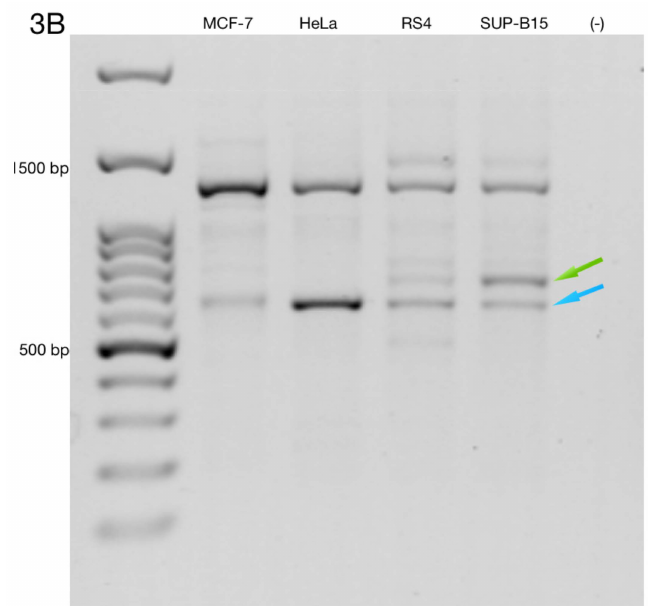
Figure 3. Rapid amplification of 3 (cid:48) cDNA ends for the ZNF695 transcript variants expressed in the cancer cell lines. ( A ) Expression of the RPL4 housekeeping gene. ( B ) Co-expression of di ff erent amplicons of ZNF695. We observed two expected amplicons using the designed primers, as shown by the green and blue arrows; these amplicons correspond to ZNF695_TV6 and ZNF695_TV7, respectively.